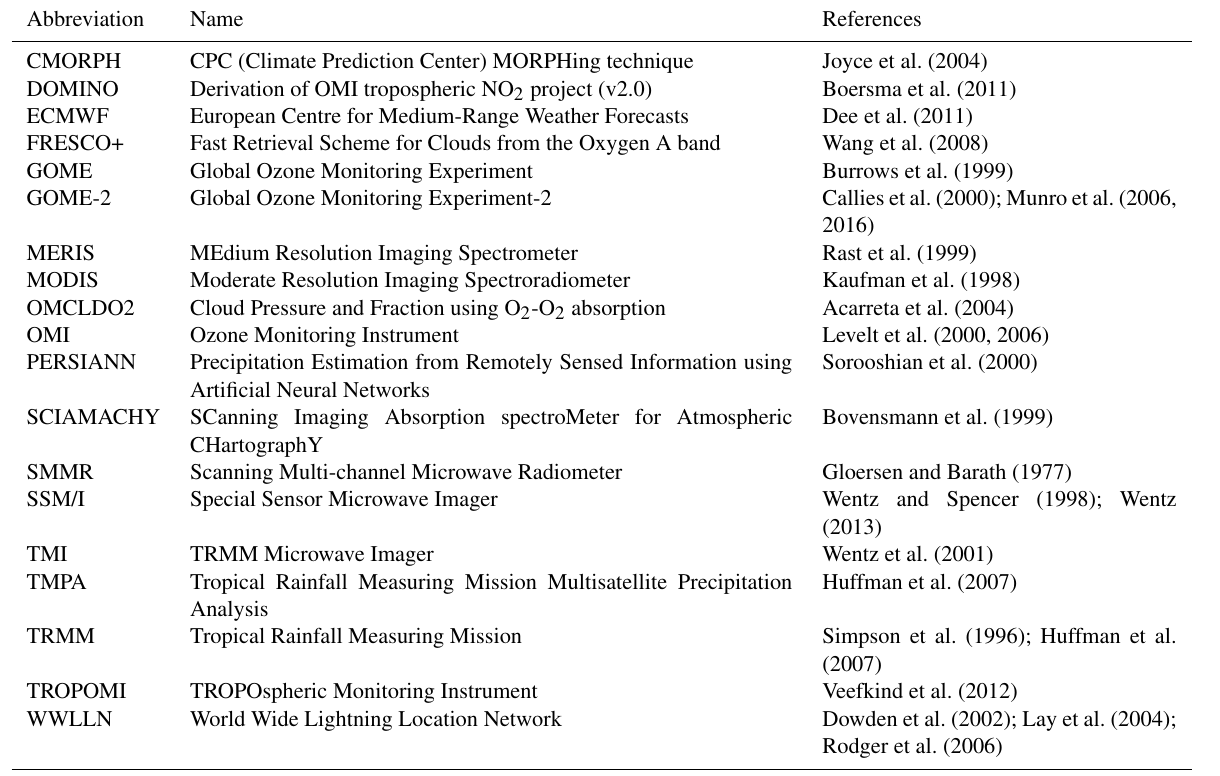
Table 1. List of acronyms for commonly used instruments and products in this